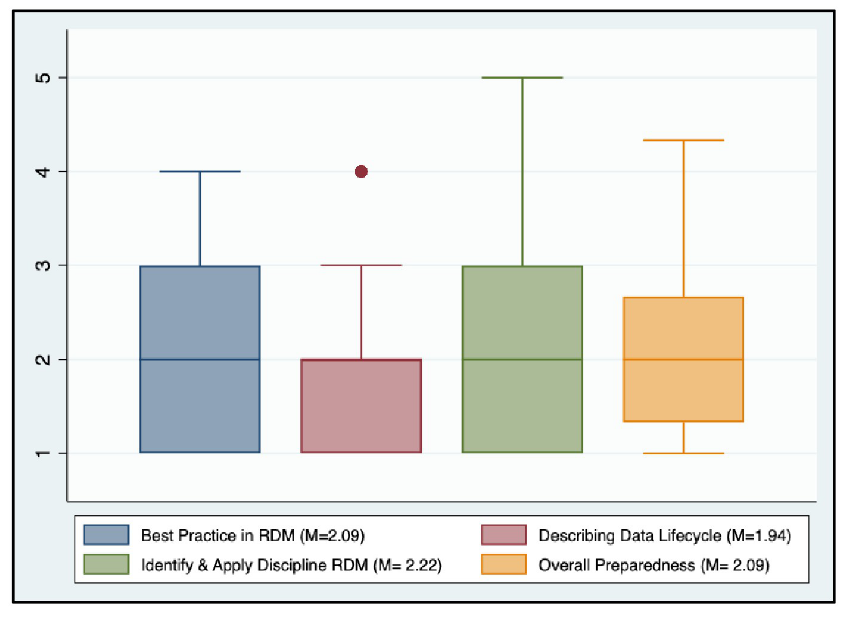
Fig 5. Preparedness for